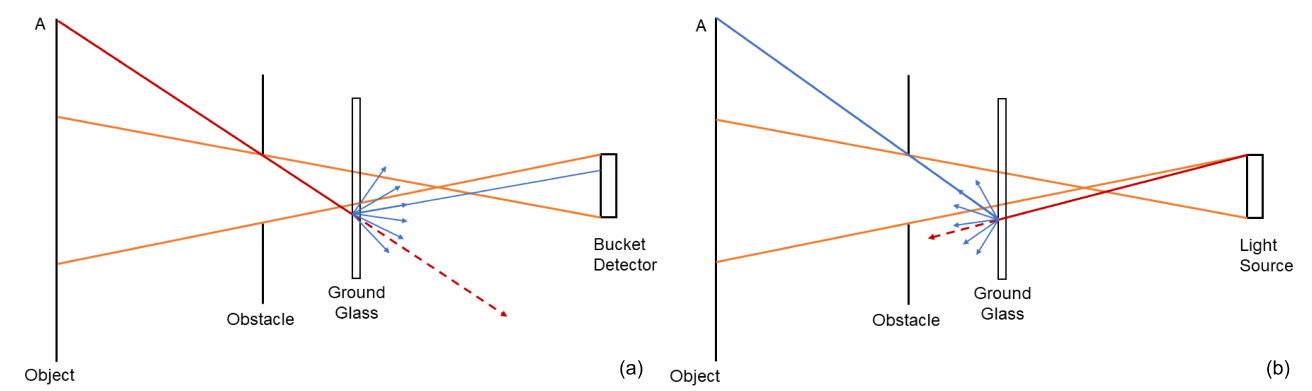
Figure 5. ( a ) Illustration of the FOV enlarged in a SPI system. Orange solid line indicates the FOV determined by the detector size, obstacle size and their distances to the object without the present of ground glass. Red solid line in indicates light from point “A” in certain propagation direction that passes through the iris, and red dash line indicates its original propagation direction without scattering. Blue lines represent scattered light of the incident light from point “A”. ( b ) Illustration of the FOV enlarged in a traditional imaging system that is in a reciprocal relationship to SPI (as we assume that the FOV is primarily limited by the illumination, the array camera is ignored in the figure). Orange solid line indicates the FOV determined by light source size, obstacle size and their distances to the object without the present of ground glass. Red solid line indicates light from top end of light source in certain propagation direction, and red dash line indicates its original propagation direction without scattering. Blue lines represent scattered light of light from the top end of light source, and part of it can propagate through the obstacle and illuminate point “A”, which means that FOV is